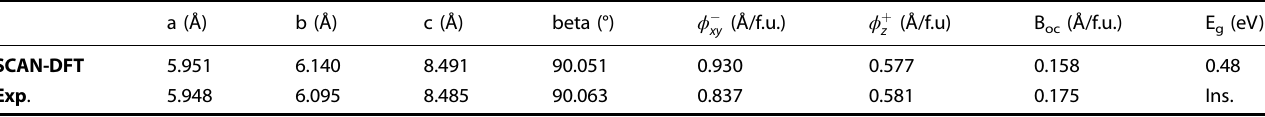
Table 1. Key structural lattice and electronic parameters from DFT and comparison with experiments.